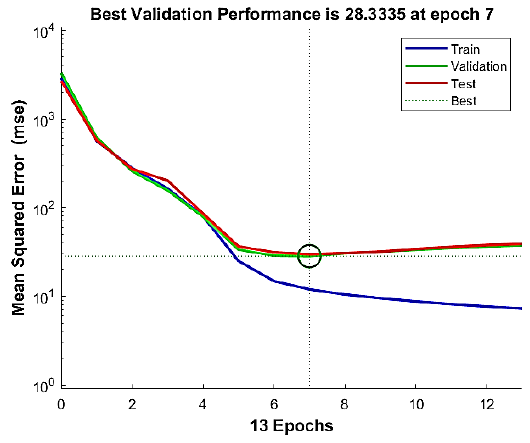
Figure 14. Two hidden layers neural network training performance.